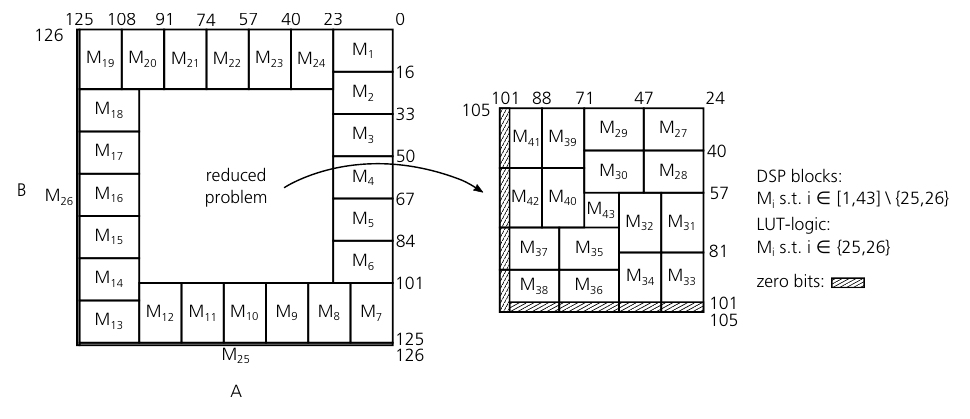
Figure 3: Architecture of the 127 × 127-bit multiplier modulo 2 127 − 1.